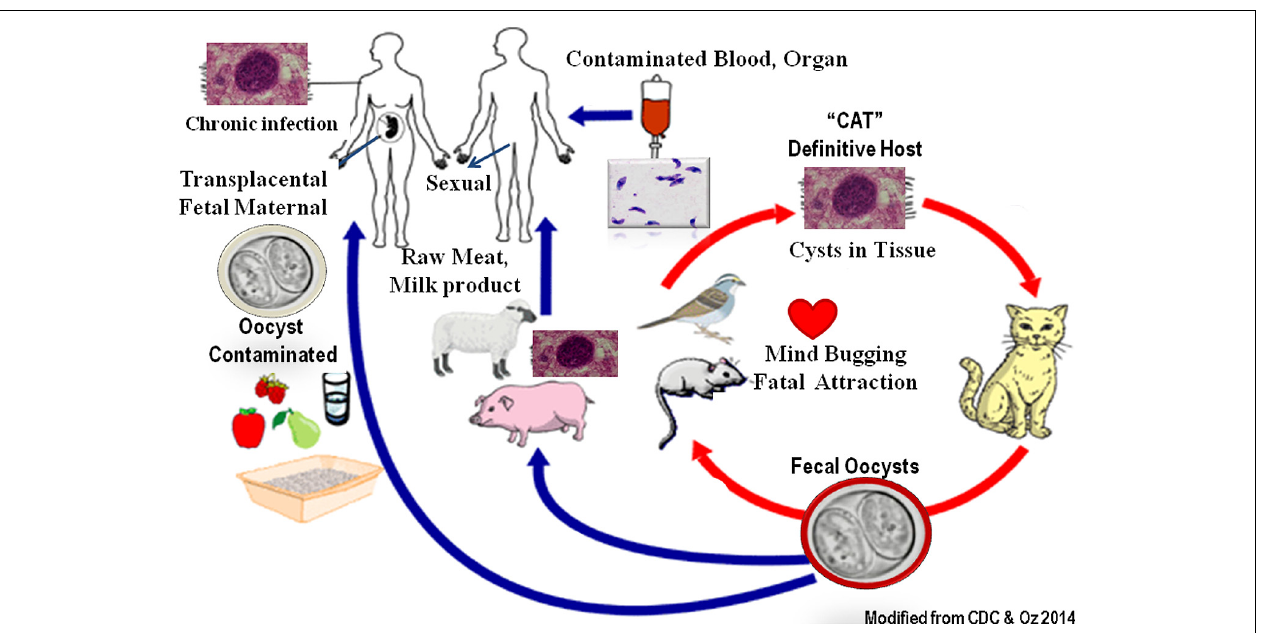
FIGURE 1 | Multiple sources of ubiquitous Toxoplasma for maternal congenital transmission.